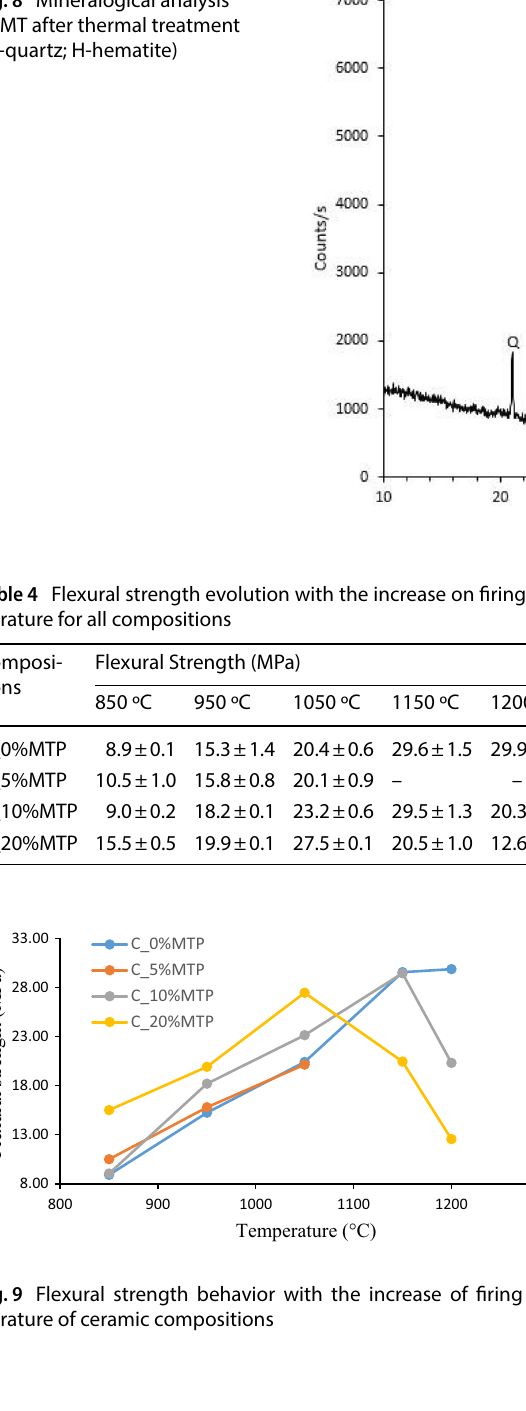
Table 5 Firing shrinkage behavior with the increase of firing temperature to all